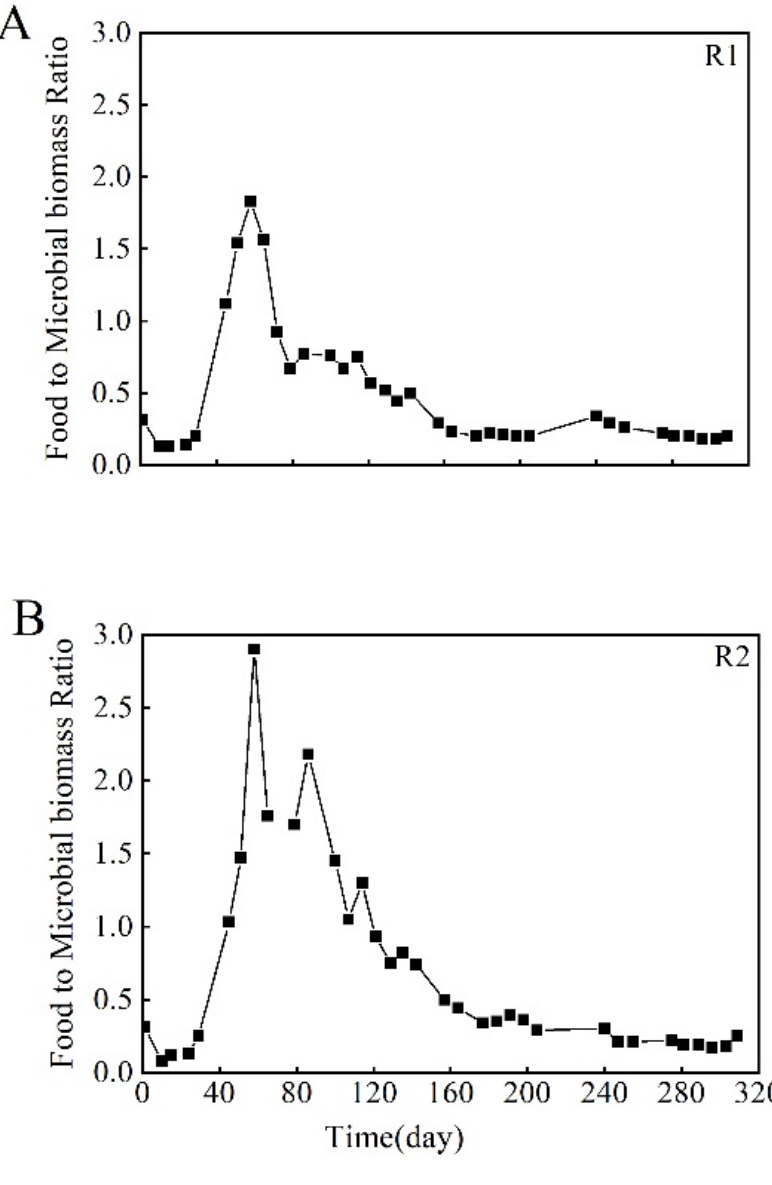
Figure 7. Food-to-Microbial Biomass Ratio in the whole operation period. ( A ) R1; ( B ) R2.